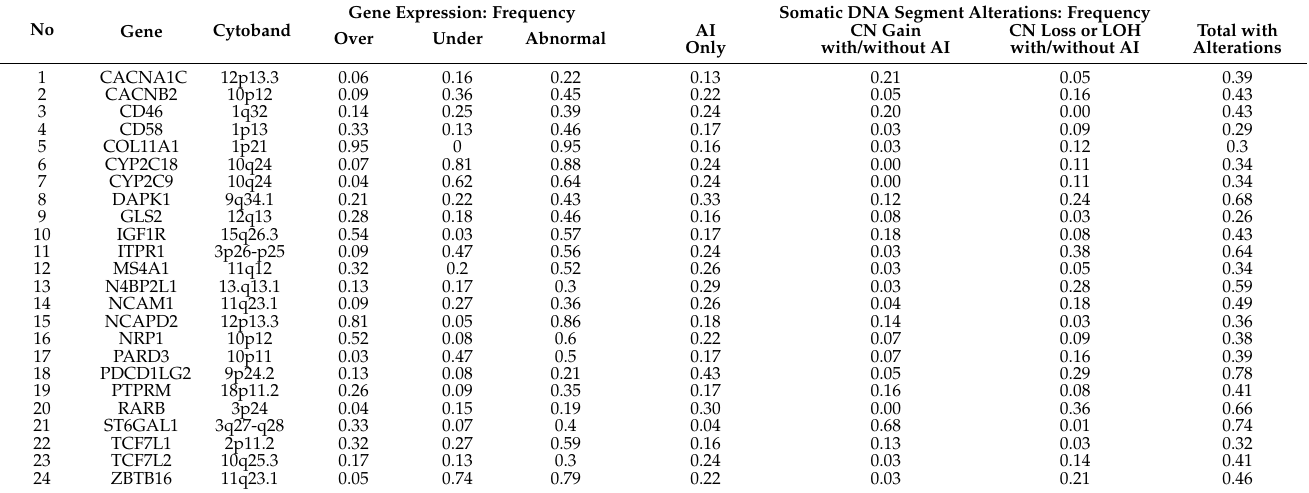
Table 2. Cross-sample characteristics of gene expression based on mRNA array ( n = 100) and somatic alterations based on SNP array ( n = 76) for the 24 genes in